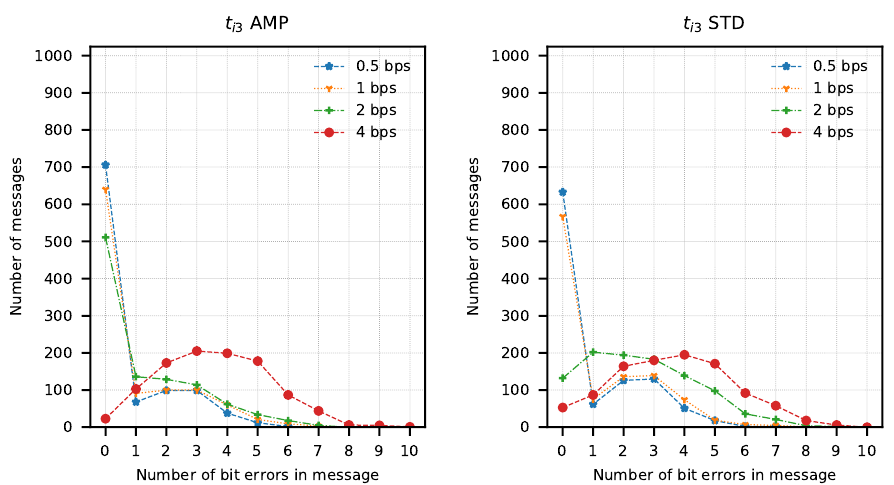
Figure 19. Number of bit errors in messages transmitted with t i 3 set calculated with amplitude analysis method (AMP) and amplitude variance analysis method (STD).